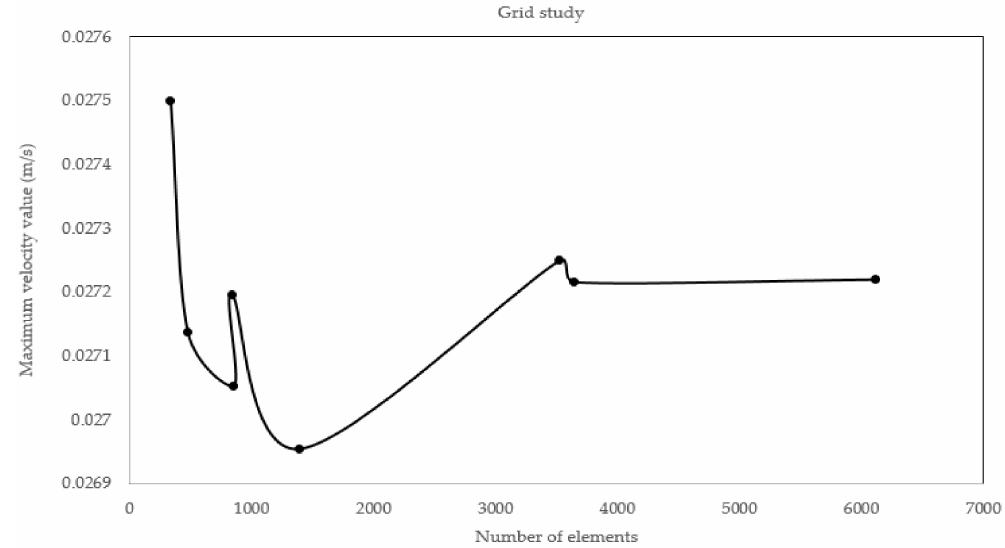
Figure 8. The way by which the domain is discretized has profound effect on accuracy of solution. Increasing number of elements increases both the accuracy and run time. The solution must be independent of element number. As can be observed, if the domain is discretized with more than 3000 elements, the maximum velocity becomes independent of number of